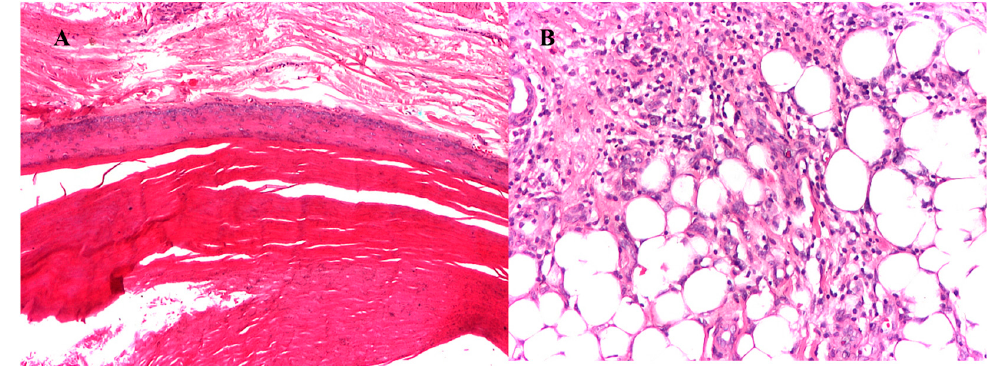
Figure 12. Epidermal inclusion cyst. ( A ) cystic wall—granular layer with lamellated keratine (HE × 10), ( B ) inflammatory infiltrated—adipose tissue (HE × 20) .